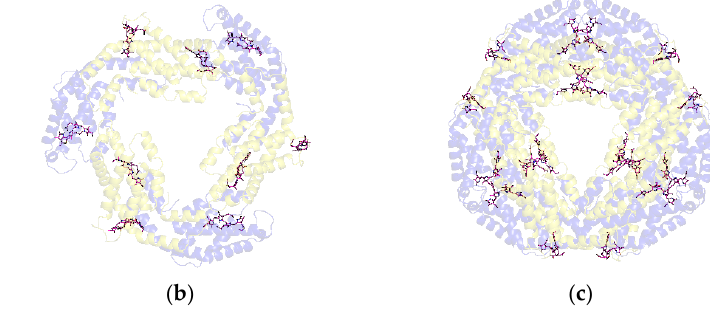
Figure 3. Distribution of chromophore arrangement in C − PC from S. platensis : ( a ) chromophores arrangement in αβ monomer, ( b ) chromophores arrangement in (αβ) 3 trimer, ( c ) chromophores arrangement in (αβ) 6 hexamer.